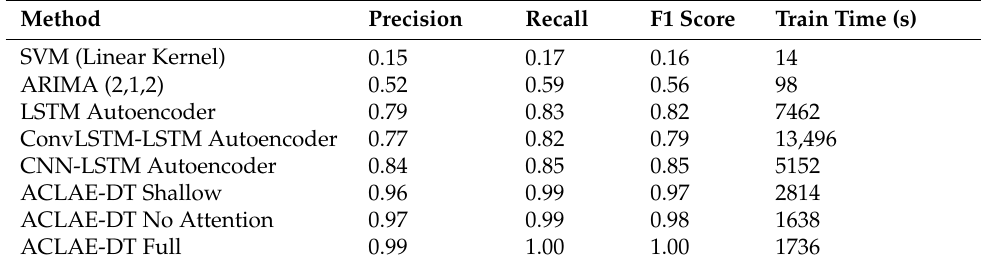
Table 4. Anomaly detection results using a window size of 60 with a step size of 10.